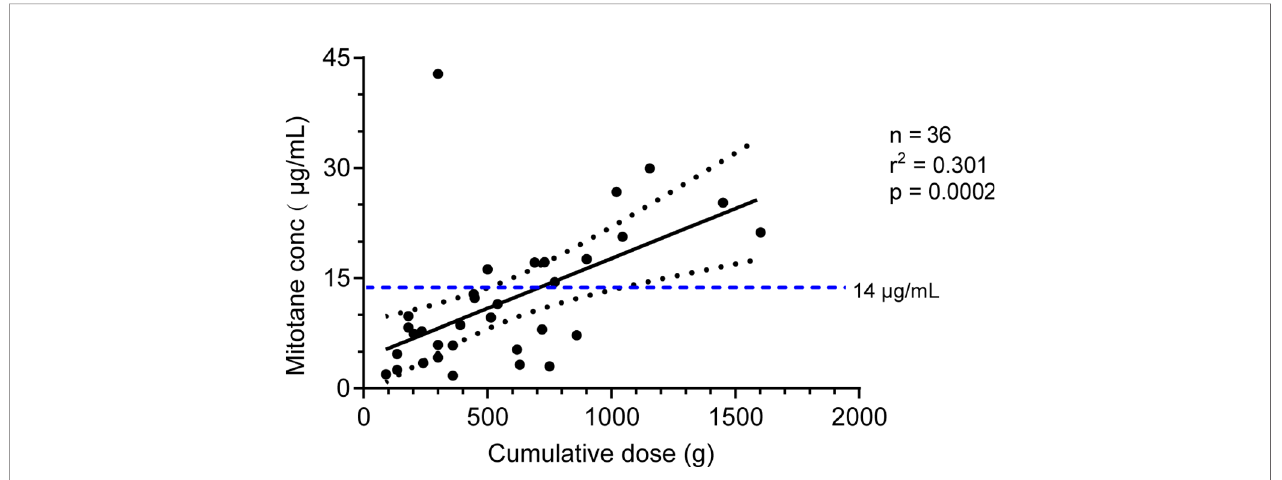
FIGURE 3 | Correlation between the mitotane cumulative dose and the plasma trough level. The solid line represents the linear regression according to y = 0.0137x + 3.968. The dotted lines represent the 95% con fi dence interval. The horizontal dotted line represents the 14 mg/L therapeutic levels. R: correlation coef fi cient.